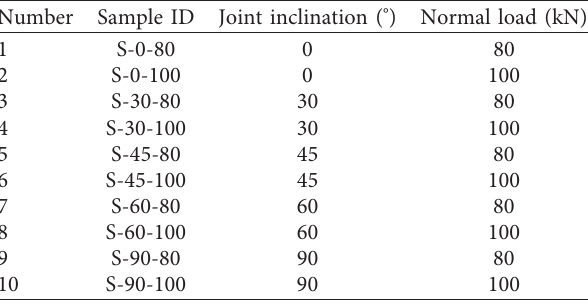
Table 2: The tested samples under the stepped excavation test.